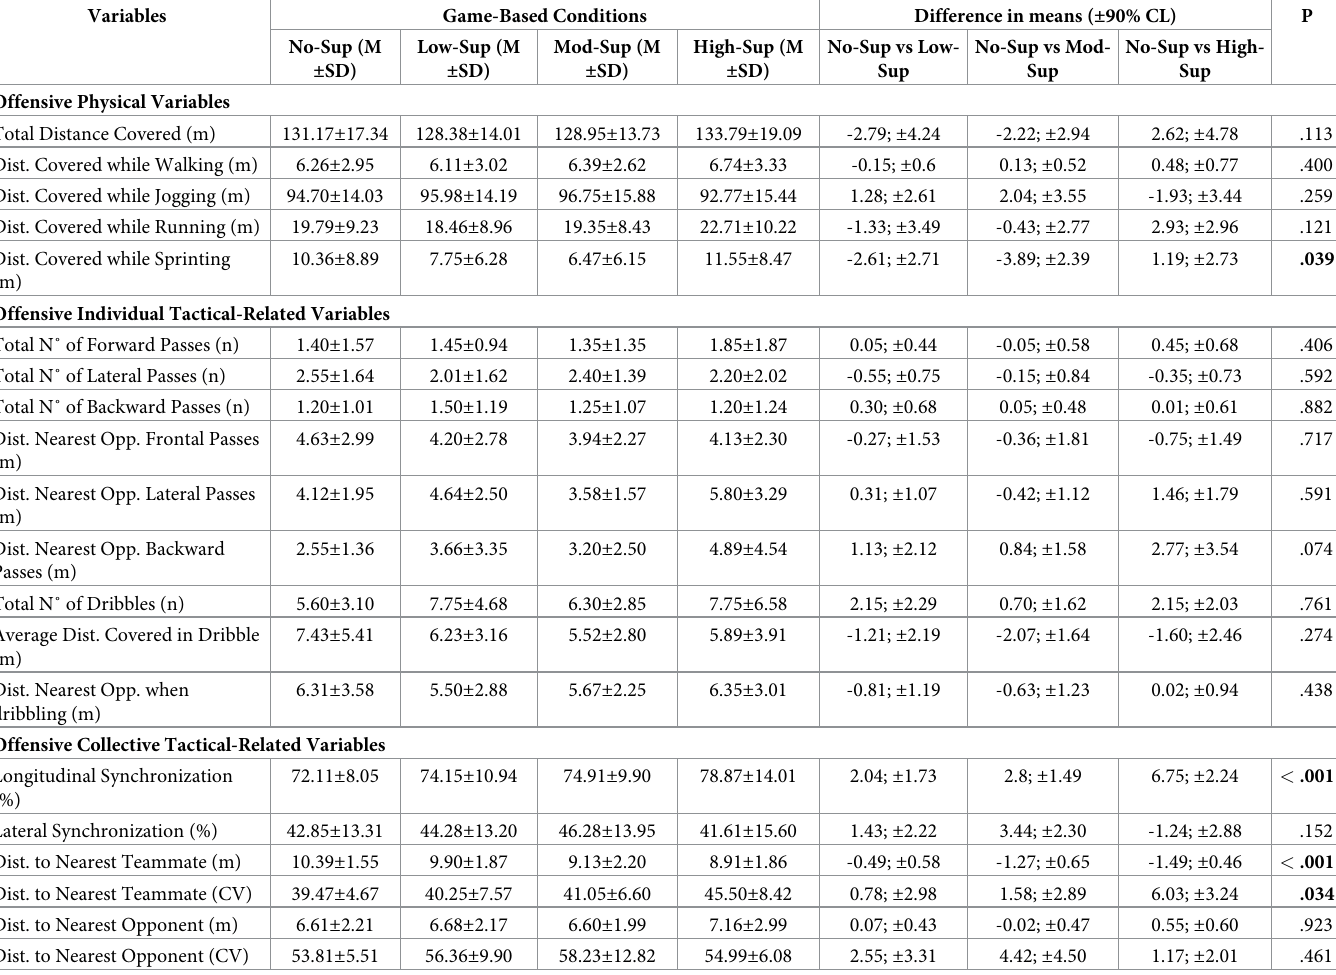
Table 1. Descriptive and statistical analysis for physical, individual and collective tactical-related variables when playing in superiority (cooperative-perspective) during the offensive phase. Variables Game-Based